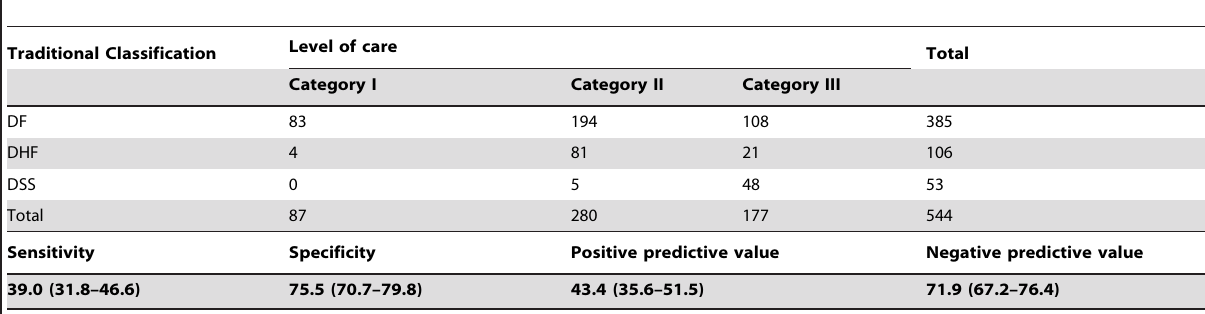
Table 4. Traditional WHO classification of severity versus level of care, 2005–2010.